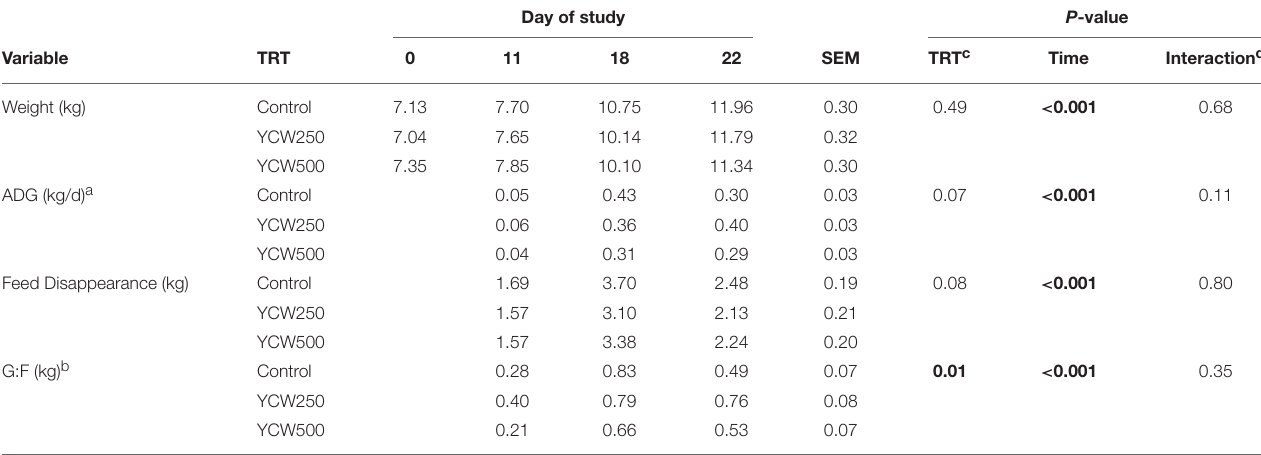
TABLE 1 | Performance parameters measured in pigs fed a control (Control) diet or supplemented with a yeast cell wall at 250 mg/kg (YCW250) or 500 mg/kg (YCW500), with administration of an oral Salmonella Typhimurium challenge on d 19. Day of study P